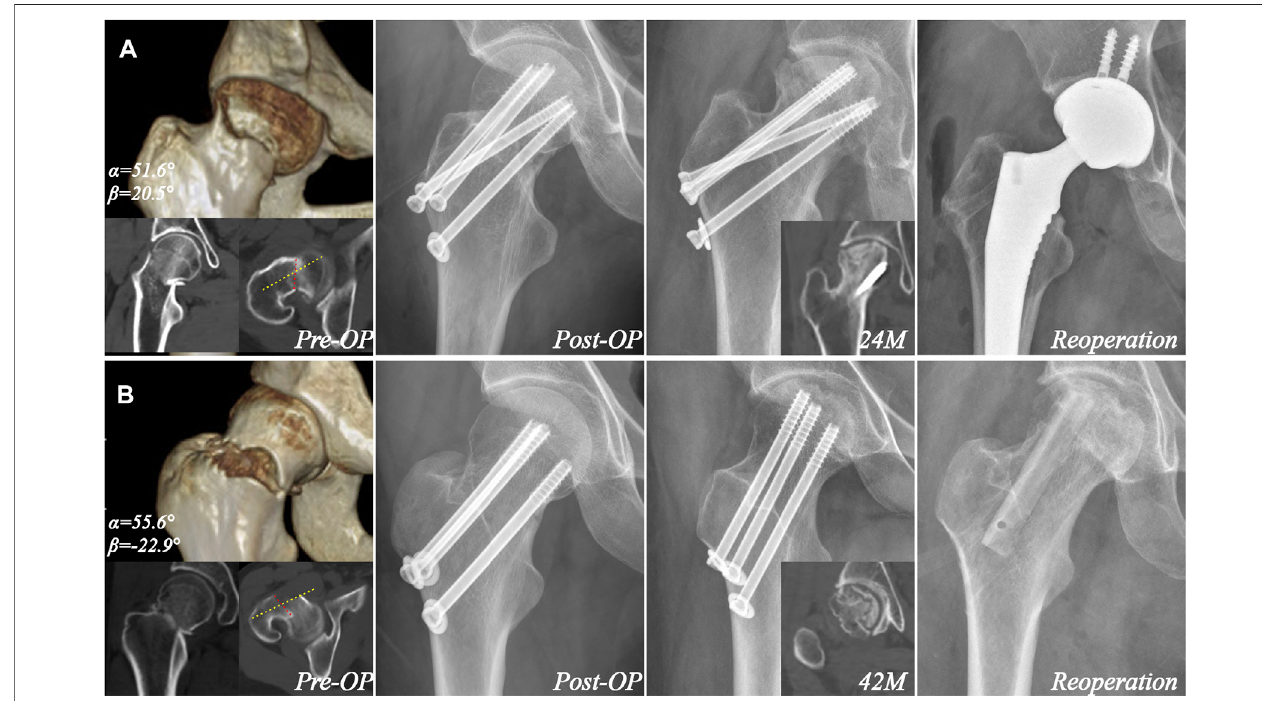
FIGURE 6 | Examples of avascular necrosis in cases with oblique unstable inclination. (A) A 42-year-old female with retroversion oblique unstable inclination angle ( α (cid:1) 51.6 ° and β (cid:1) 20.5 ° ) was treated with four cannulated screws. Radiography taken 24 months postoperatively revealed avascular necrosis, which was treated with arthroplasty. The yellow and red line showed the femoral neck axis and fracture orientation in one CT plane. (B) A 32-year-old female with anteversion oblique unstable inclination angle ( α (cid:1) 55.6 ° and β (cid:1) − 22.9 ° ) was treated with three cannulated screws. Radiography taken 42 months postoperatively revealed avascular necrosis, which was treated with free vascularized fi bular grafting. The yellow and red line showed the femoral neck axis and fracture orientation in CT plane.